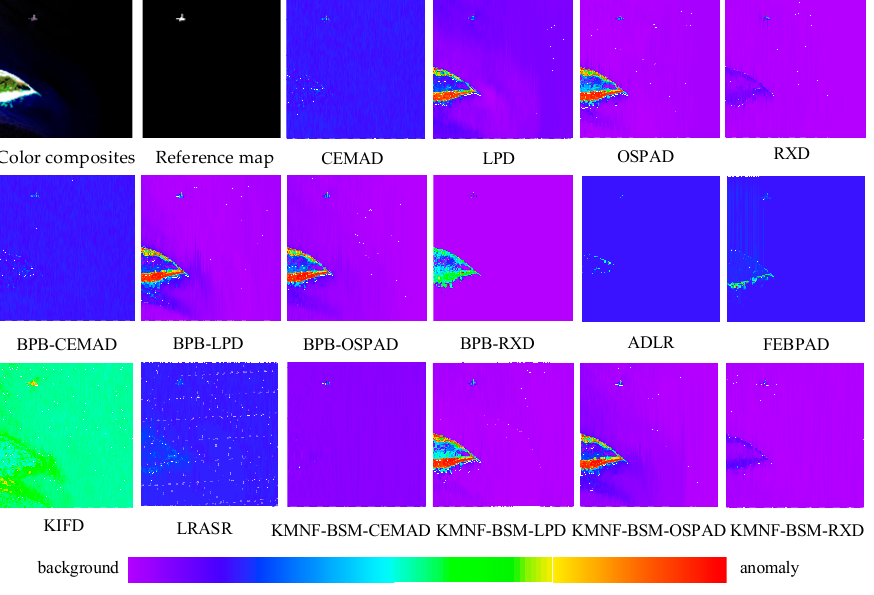
anomaly Figure 6. The detection maps of different detectors for the urban scene.